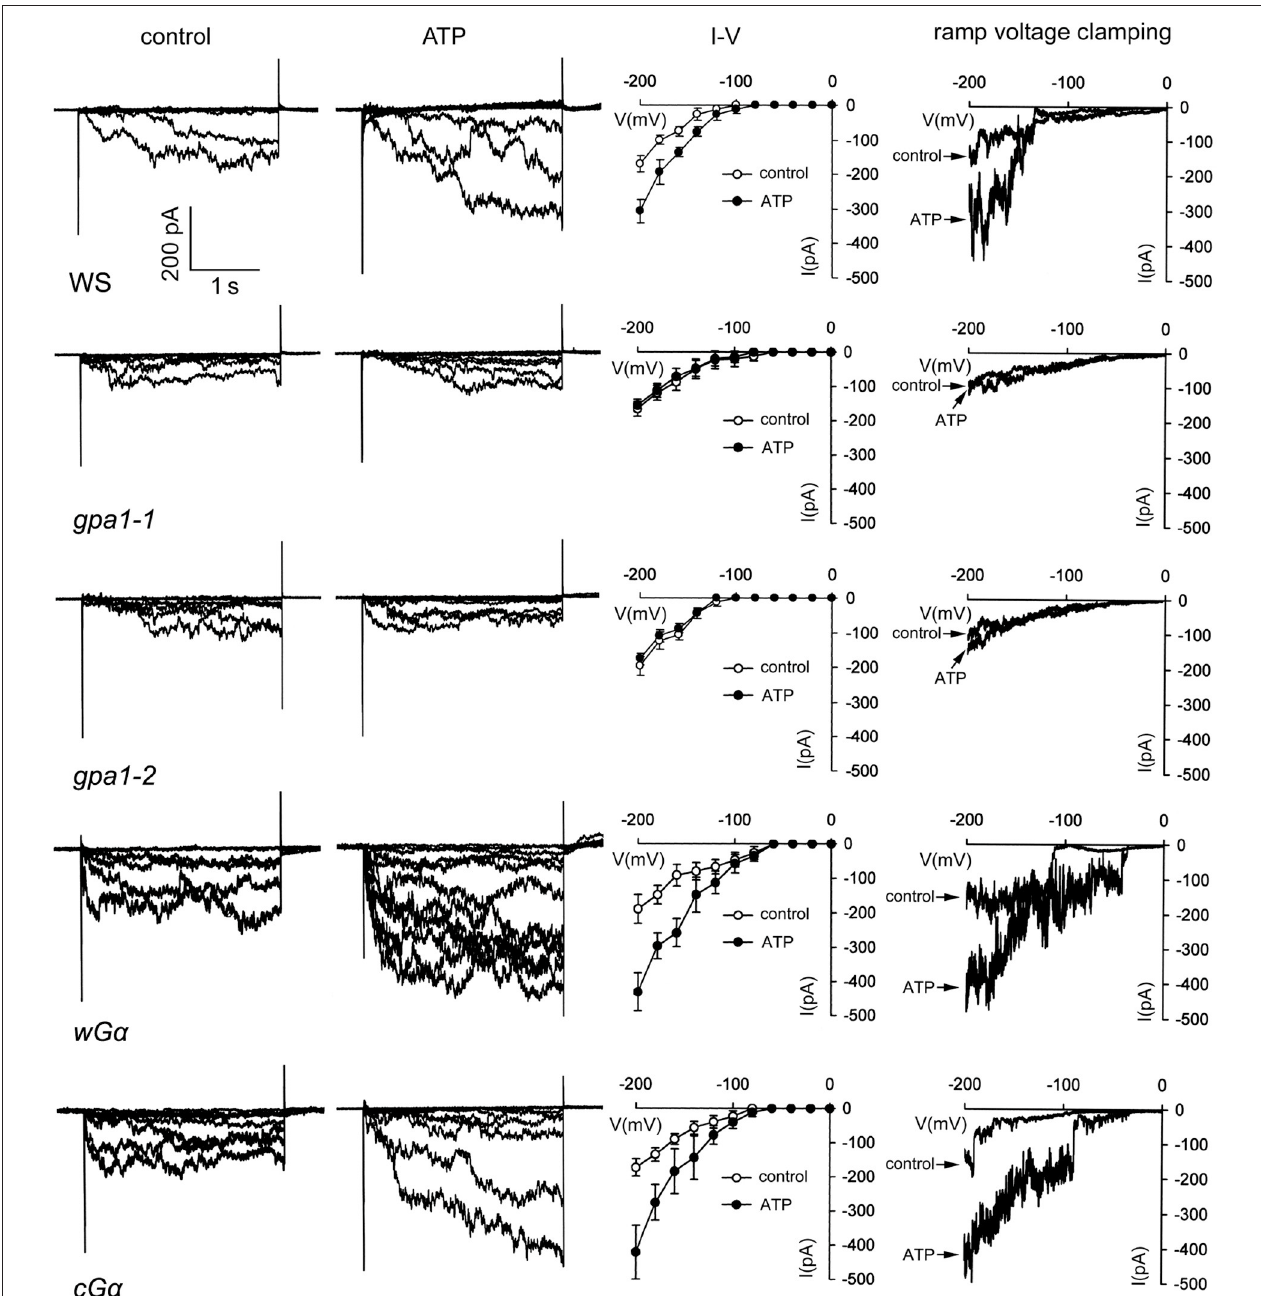
FIGURE 4 | Heterotrimeric G α is involved in eATP-stimulated Ca 2 + influx in root cells. Ca 2 + influx across the PM of root cell protoplasts was detected by whole-cell voltage clamping. Results from step-(1st to 3rd column) and ramp-(4th column) voltage clamping recordings in wild type (WS), G α null mutants ( gpa1-1 and gpa1-2 ) and OE lines ( cG α and wG α ). In each line, current traces before (control), and after 0.1 mM ATP treatment are shown in the 1st and 2nd column, respectively. The 3rd column shows the I–V relationship curve of step-voltage clamping ( n = 6). The 4th column notes the current traces before and after 0.1 mM ATP treatment which were recorded by slow ramp-voltage clamping. The genotype is marked below each line on the left. The time/current intensity scale bar is showed on the lower left of the first line.